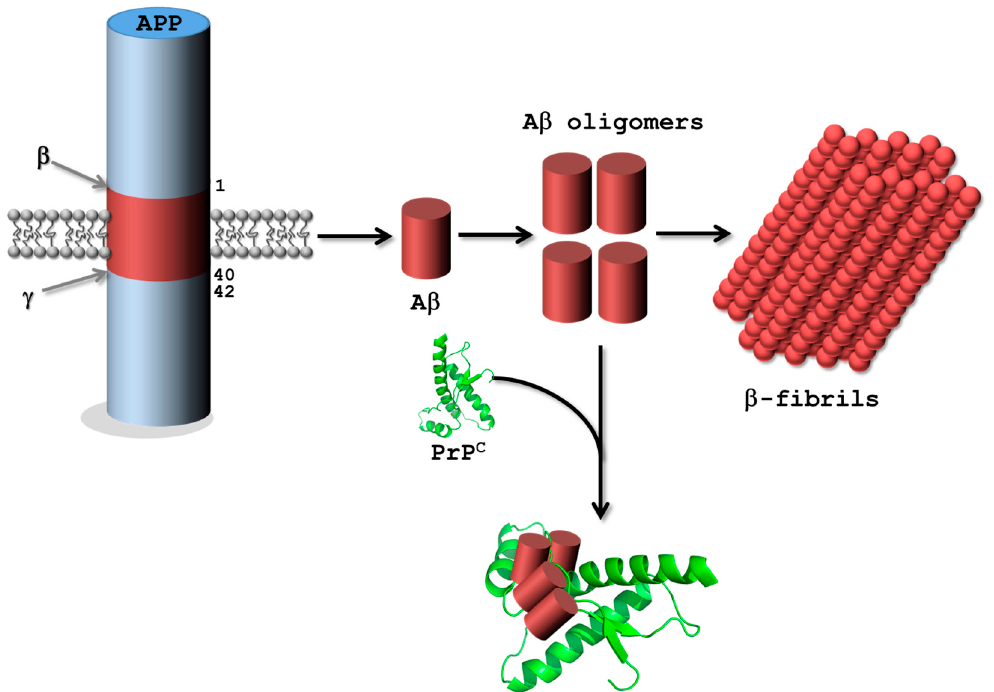
Figure 4. Schematic depiction of the formation of A β fibrils: BACE1 cleaves APP (A β sequence numbers are shown only) in the extracellular domain and the resulting fragment remains membrane-bound where it is cleaved by the γ -secretase complex into A β peptides (only the main A β 40 and A β 42 isoforms are shown). Monomeric A β peptides then aggregate to form oligomers and eventually β - fibrils. The cellular prion protein PrP C can also bind to A β oligomers [78,119].